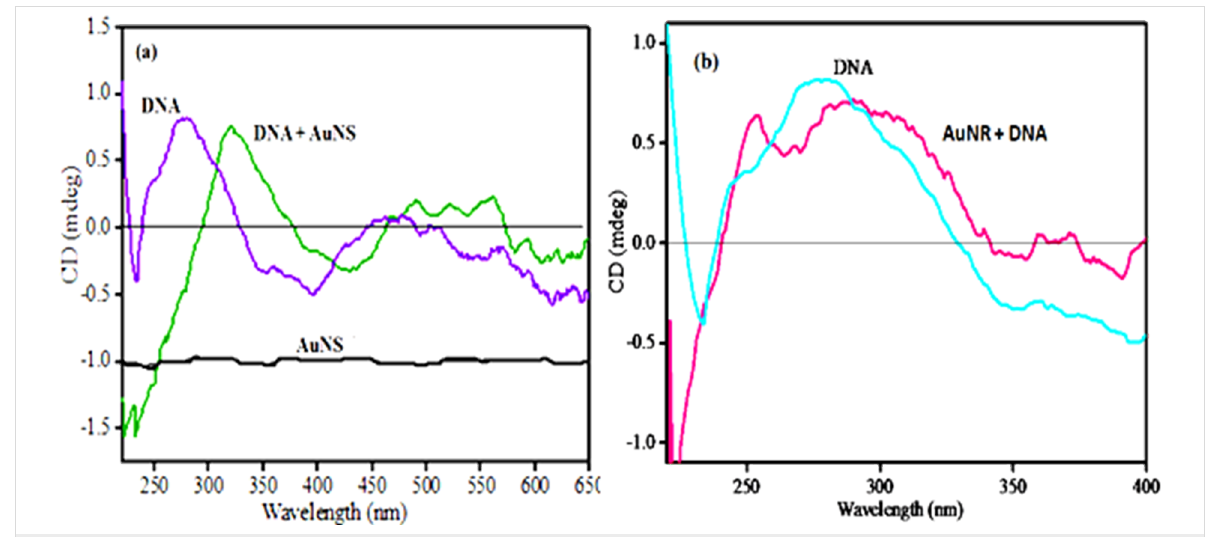
Figure 2: Circular dichroism spectral changes in the DNA conformation upon binding with (a) Au nanospheres and (b) Au nanorods.